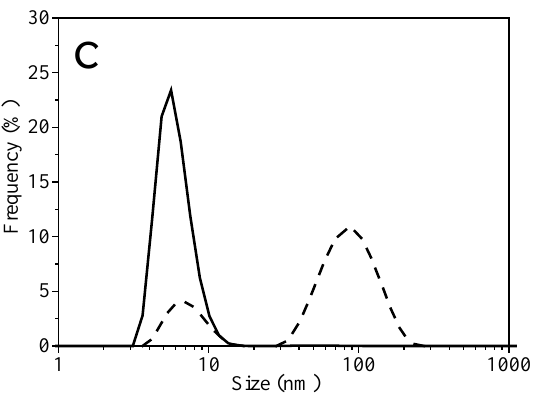
Figure 7. DLS plots for size distribution profiles of AuNPs synthesized at 30 °C with Pluronic P103 at different concentrations (wt%): ( a ) AuNPs P103 0.5%; ( b ) AuNPs P103 1%, and ( c ) AuNPs P103 10%. Intensity size distribution (dashed line), volume size distribution (continuous line). ( d ) TEM for AuNPs P103 10%.